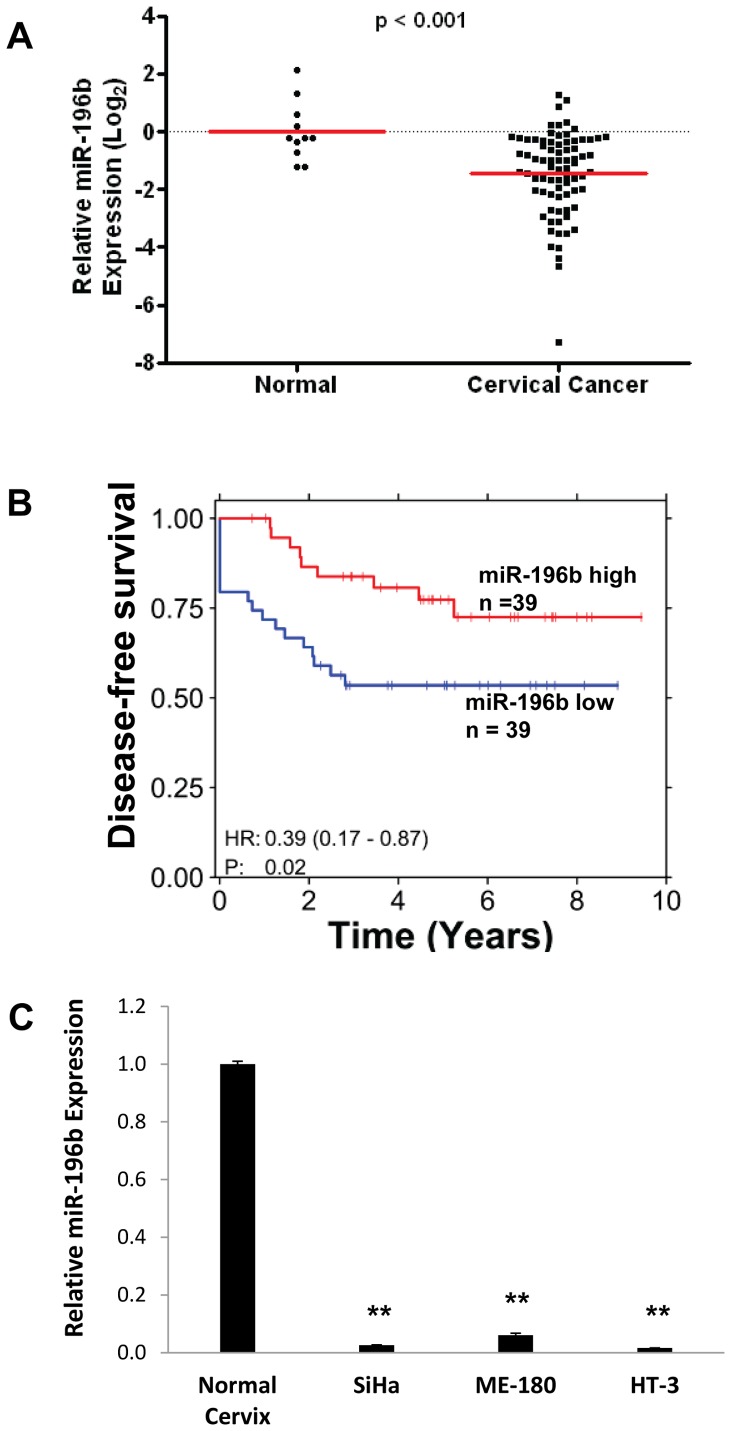
miR-196b down-regulation in cervical cancer.
A) miR-196b expression levels were measured using qRT-PCR in 79 primary cervical cancer samples, compared to 11 normal cervix epithelial tissue controls. B) Kaplan-Meier analysis of DFS in patients with cervical cancer. Red, patients with higher than median miR-196b expression level (n = 39); blue, patients with lower than median miR-196b expression (n = 39); one patient was removed from survival analysis due to missing survival information. C) Basal levels of miR-196b in three cervical cancer cell lines (SiHa, ME-180, and HT-3), as compared to normal cervix epithelial tissues, assayed by qRT-PCR. **P<0.01.